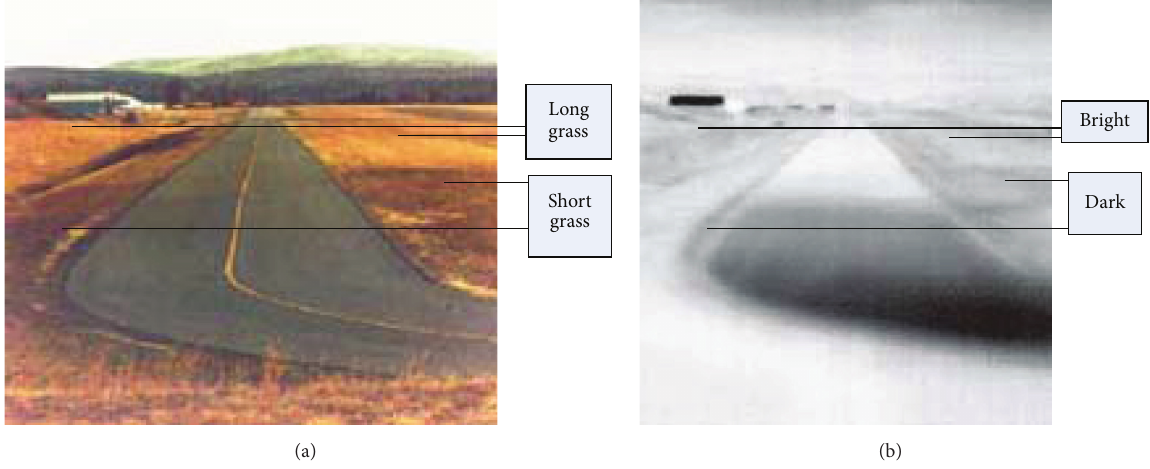
Figure 9: Optical image and measured image of airplane